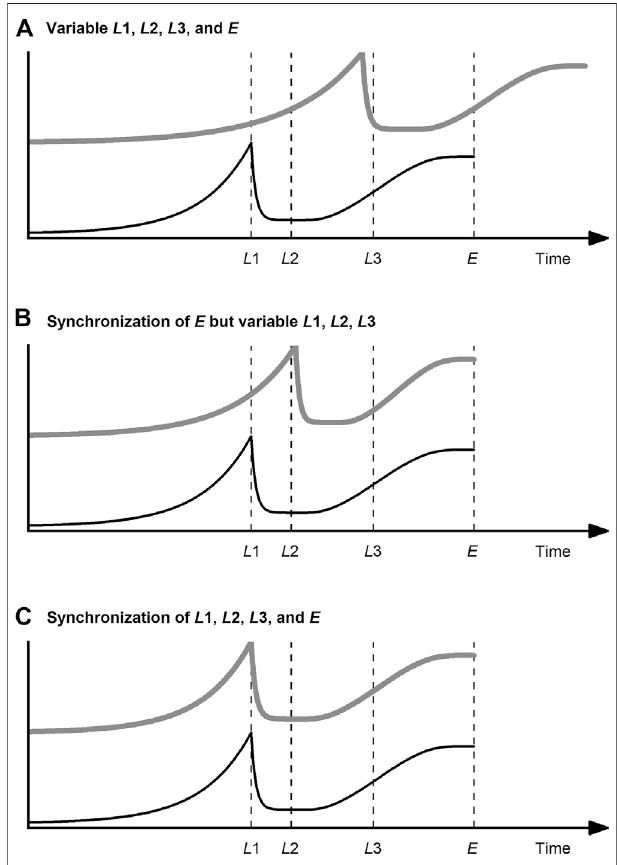
FIGURE 3 | Data synchronization of a query curve (gray, thick line) related to a reference curve (black, thin line) of a fi ctional process variable with landmarks L 1, L 2, and L 3 and process end E (dashed line): (A) Initial situation with variable E and variable L 1, L 2, and L 3; (B) Synchronization of E but no coincidence of L 1, L 2, and L 3; (C) Synchronization of E , L 1, L 2, and L 3. The landmarks L 1, L 2, and L 3 represent typical curve features, namely a local maximum, a local minimum, and a trend reversal, respectively. The trigger event for this fi ctional process to end ( E ) is the reaching of a plateau after L 1, L 2, and L 3 have been